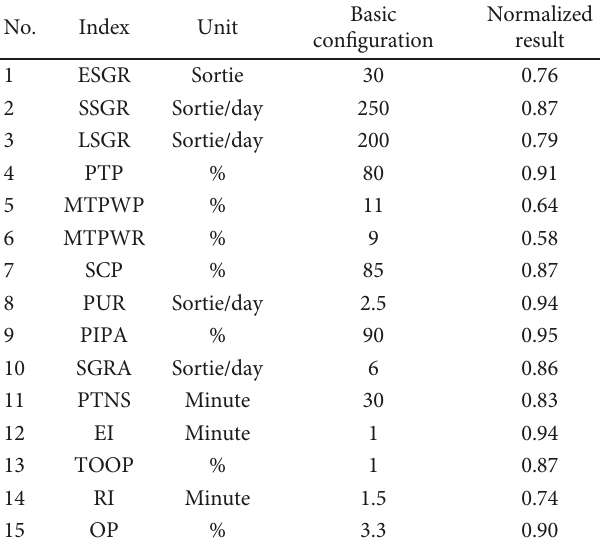
Figure 14: Evaluation error of the sortie generation capacity of the carrier aircraft. Table 8: The reference